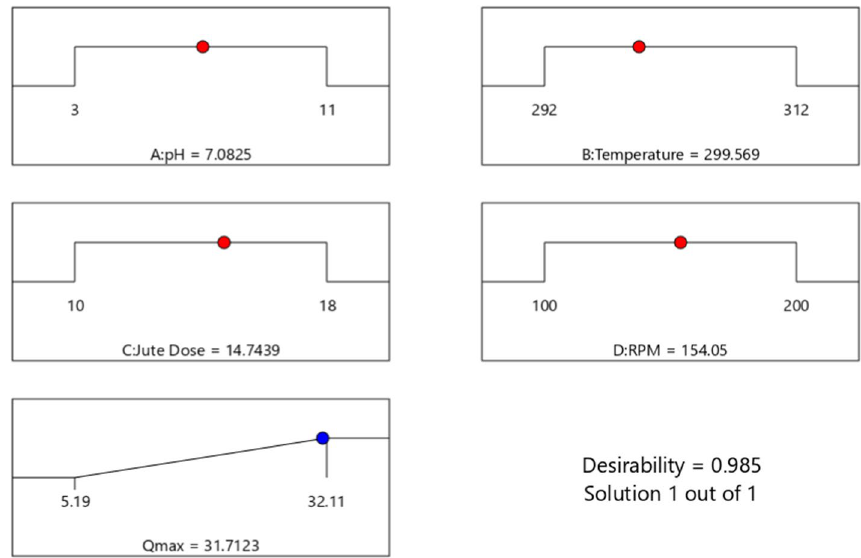
Fig. 21 Ramp function plot of desirability for Q